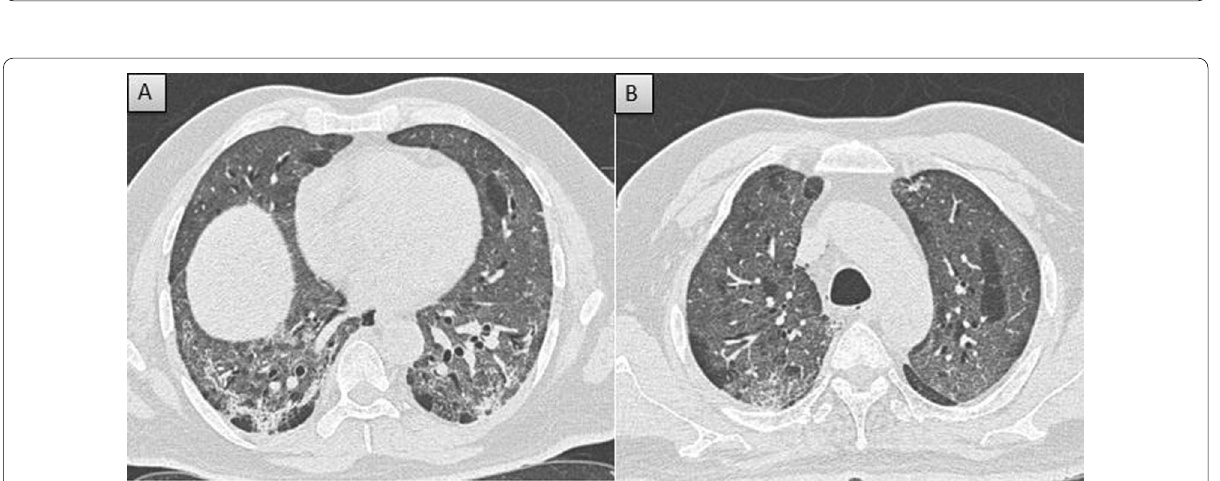
Fig. 5 Severe severity in non-vaccinated patient: A and B Axial CT thorax (lung window) of a 57-year-old non-vaccinated COVID pneumonia patient shows diffuse confluent ground glass opacities with CT severity score of 22/25 (severe